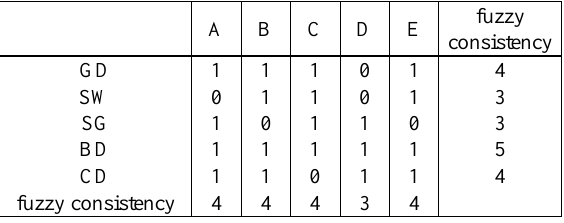
Table 1 . Example of fuzzy consistency for single geographical names.